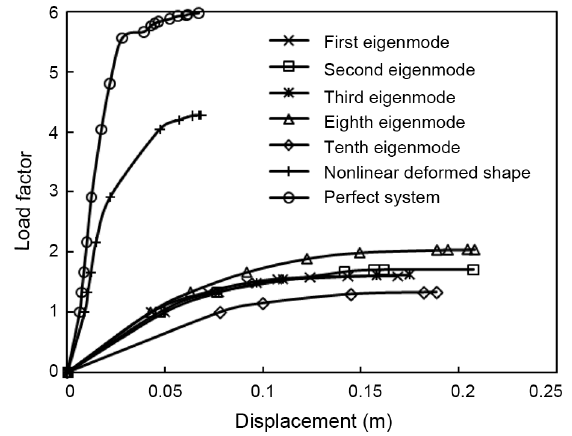
Fig. 9. Load-displacement curves for imperfect structures, loading case g + s